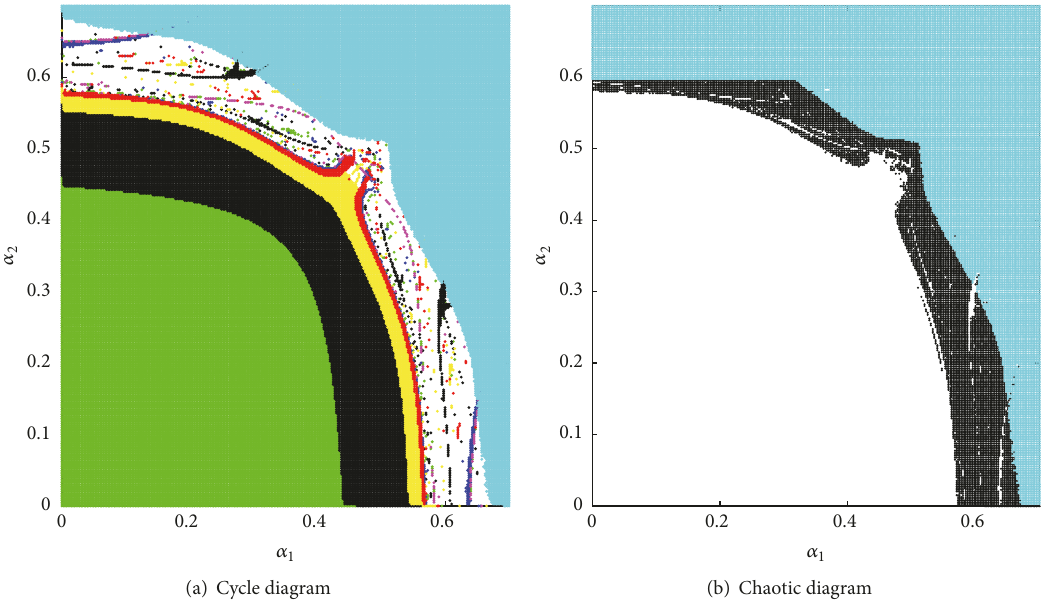
Figure 4: Cycle diagram and chaotic diagram of the system with the adjustment speeds 𝛼 1 , 𝛼 2 at the same time.